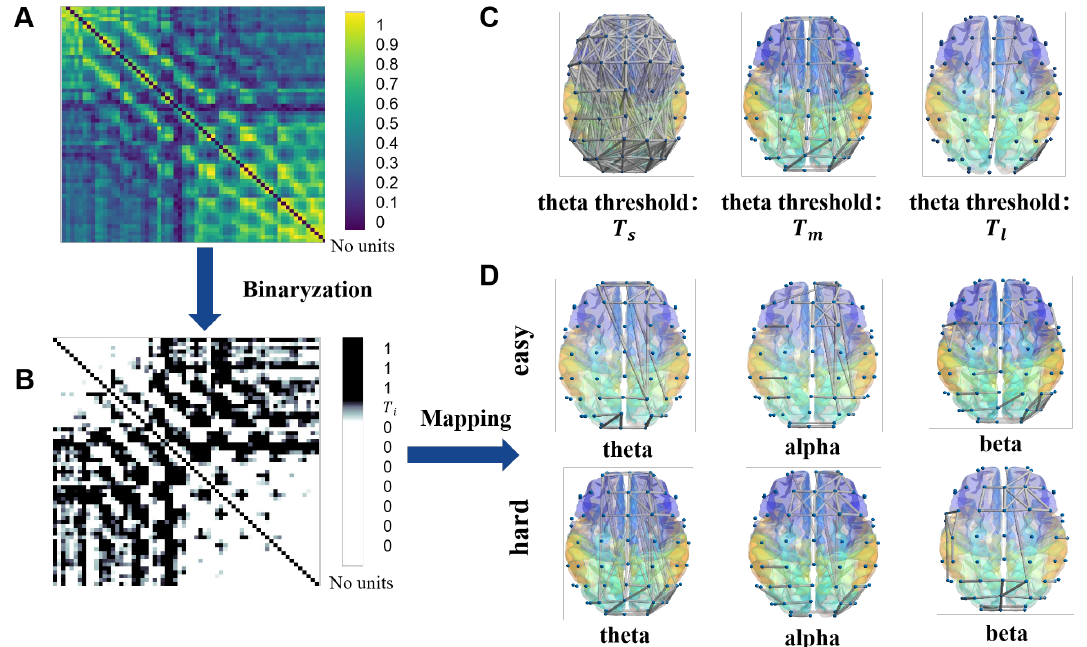
Figure 4. The binarization of the brain network. ( A ) The adjacent matrix of the PLV generated by a group of sampled data. ( B ) The binarized adjacent matrix. The PLV between two electrodes will be 1, if it exceeds the threshold T i and 0 if it is below the threshold T i . ( C ) The brain network in the theta band is constructed under different threshold. The edge between the nodes are drawn when the PLV exceed the threshold. The diagram is drawn by the Brain Net Viewer [41]. Considering the PLV will decrease with the frequency increasing, each band must set its own thresholds to establish uniform standard. ( D ) The binarized brain network under the easy task and hard task states. In each band, the thresholds are set